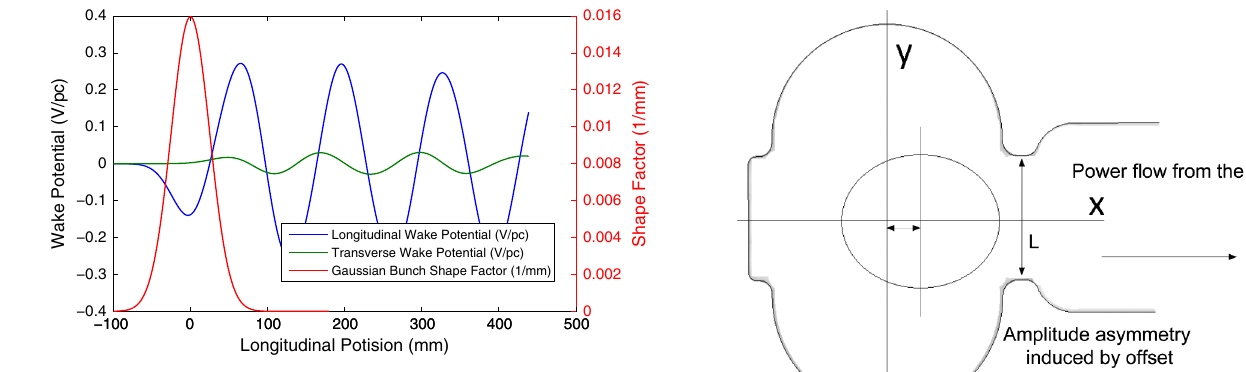
FIG. 6. Gaussian drive bunch distribution and excited longi- tudinal and transverse wake potential. The rms length of the bunch is 25 mm.